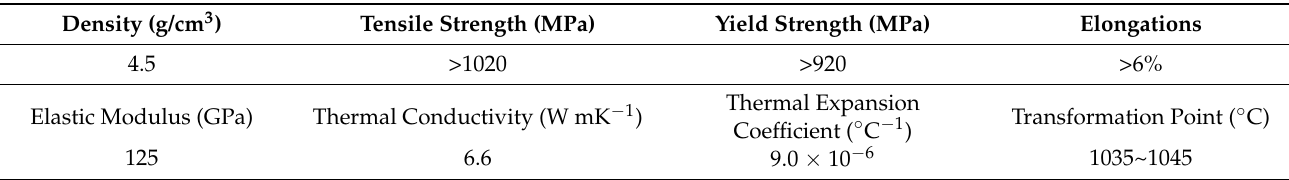
Table 2. Physical properties of (TiB+TiC)/TC4 composites at 20 ◦